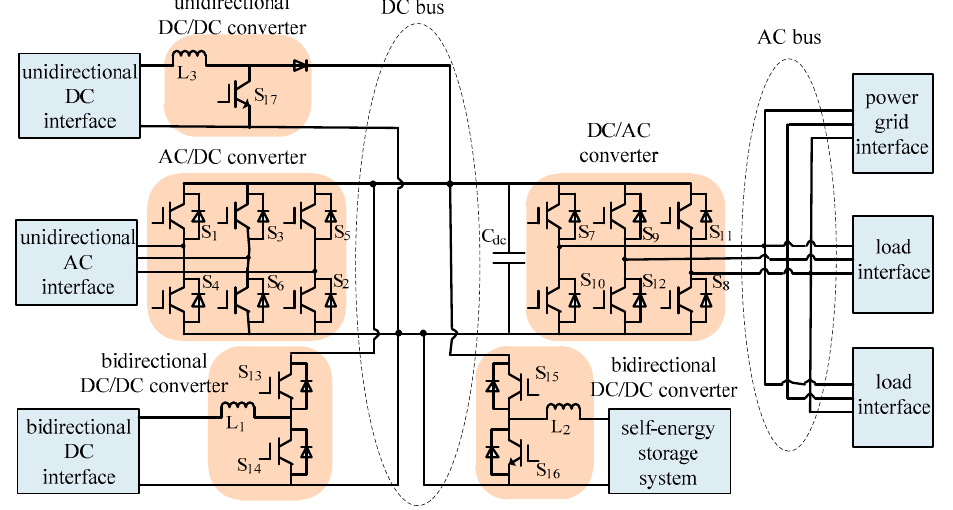
Figure 3. Power electronic converters in the energy router.